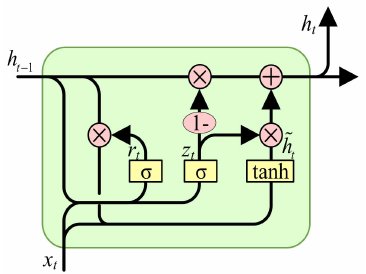
Figure 2. Structure diagram of a